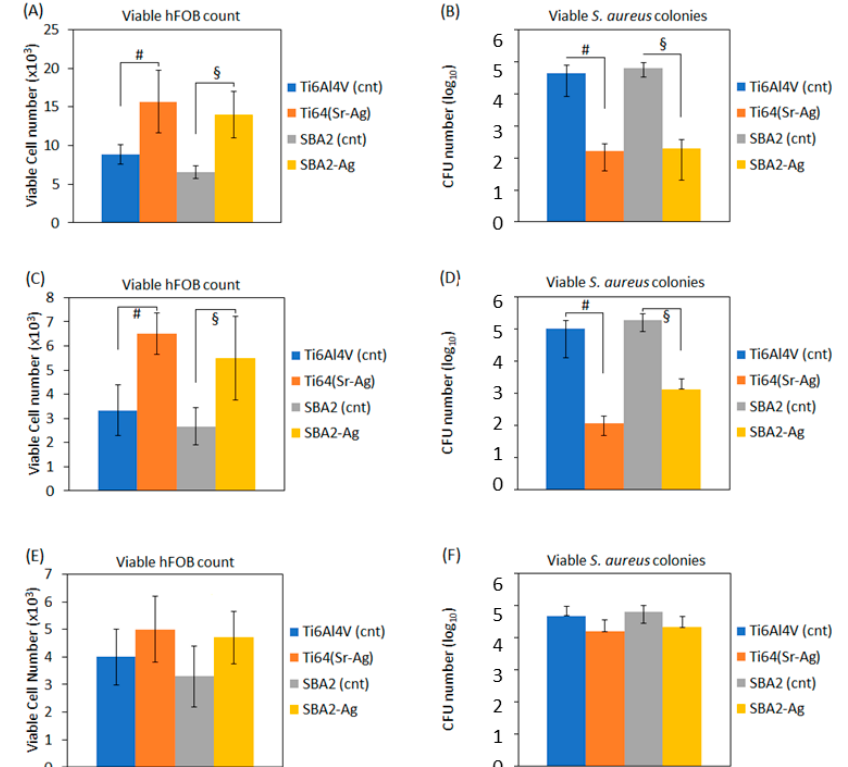
Figure 7. The results from the osteoblasts-bacteria co-cultures for the protection ( A , B ), prevention ( C , D ) and competition ( E , F ) methods. The surface treatments were able to both protect osteoblasts (( A ) p < 0.05 vs. cnt, indicated by # and §) and prevent them from infection (( C ), p < 0.05 vs. cnt, indicated by # and §) by significantly lowering the number of S. aureus CFU (( B , D ), p < 0.05 vs. cnt, indicated by # and §). However, in the competition method, Ag doping did not report significant differences in comparison with controls for both viable osteoblasts and bacteria CFU count (( E , F ), p > 0.05). Bars represent means and standard deviations.